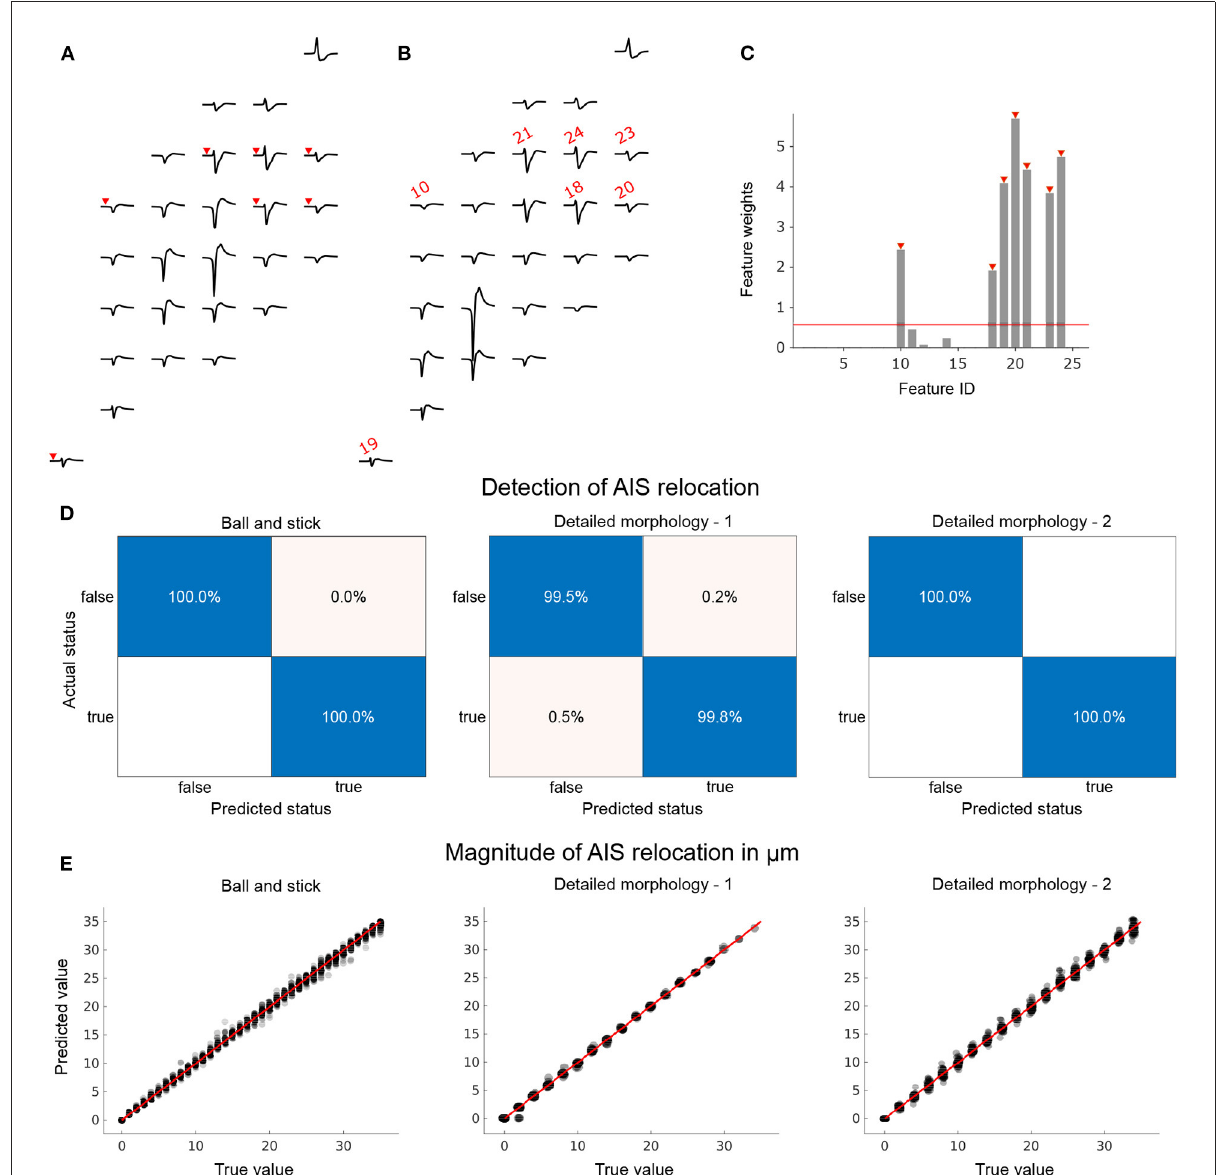
FIGURE5 Models to reliably detect AIS relocation and predict its magnitude can be trained by using a family of extracellular activity simulations initialized by the respective baseline morphologies. We pre-selected a subset of electrodes from the extracellular footprints to constrain the feature space for statistical learning. 26 electrodes with the highest amplitudes in baseline configuration (initial AIS position) were pre-selected. Amplitude changes at these electrodes were computed between baseline (A) and relocated (B) extracellular footprints. The footprints shown were based on a ball-and-stick model with a 30 ◦ rotation with AIS positions at 5 µ m (baseline) and 40 µ m (relocated). (C) For the detection of AIS relocation, an additional feature-selection step using neighborhood components analysis (NCA) was performed. Feature IDs marked in red (corresponding electrodes in (A,B) are marked in red with arrowheads or the feature IDs) were selected to train the classifier (relocation status detector). (D) The trained classifiers performed very well on the held-out test data sets for each of the three neuron models. True positive rates were high and false positives were negligible or non-existent (blank fields). (E) Changes in amplitude were used to train a regression model to predict the magnitude of AIS relocation. Trained models were tested using held-out data sets and showed remarkable predictive power for each neuron